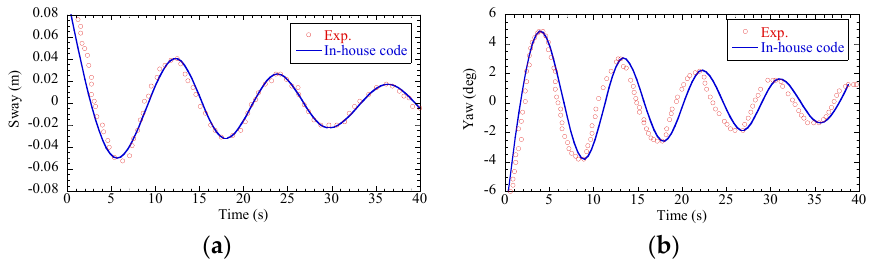
Figure 7. Comparison of the sway and yaw responses between the experiment and the in-house developed code. ( a ) sway; ( b ) yaw.